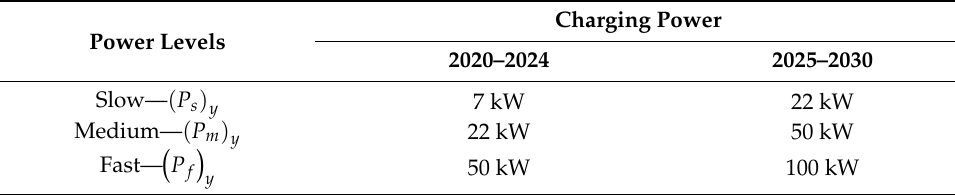
Table 8. Charging power levels assumed in the model for this study.